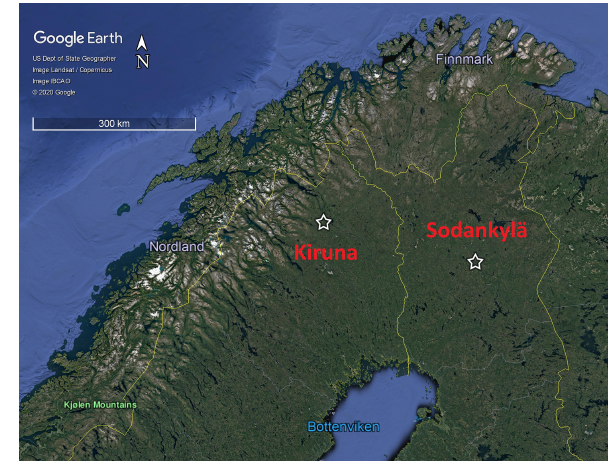
Figure 1. Map showing locations of the Kiruna and Sodankylä sites in this